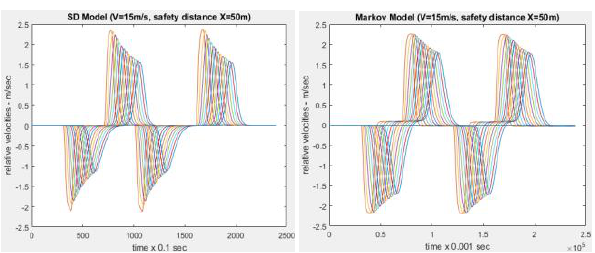
Fig. 14. The impact of Markov model parameters on the velocities.